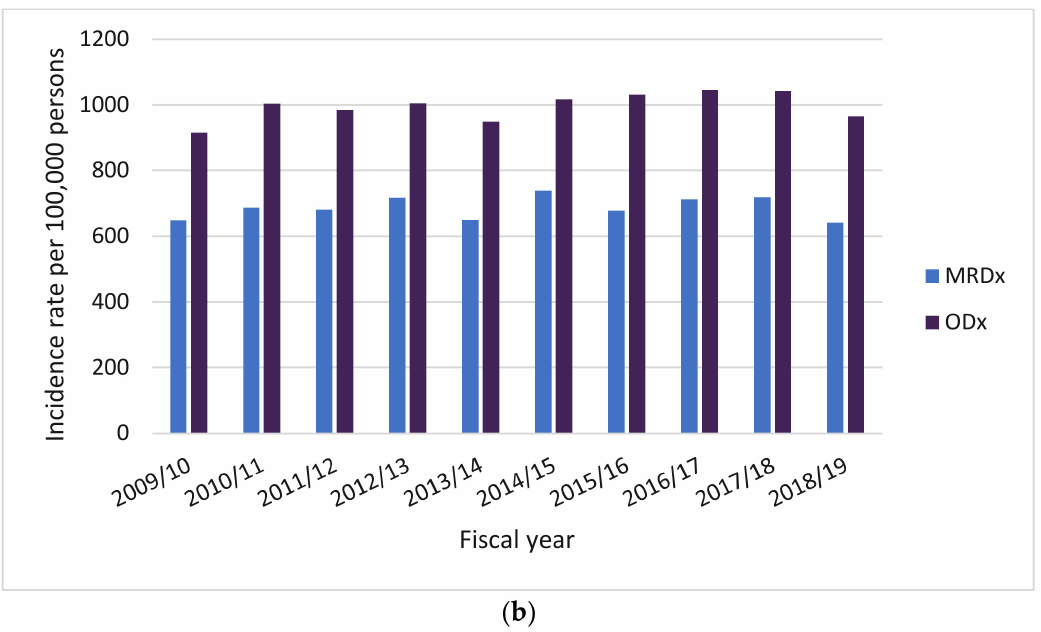
Figure 2. Incidence rates of acute-care hospitalization for all-cause community-acquired pneumonia, by case coding, in fiscal years 2009–2018. Incidence rates are presented for individuals ( a ) 50–64 years old and ( b ) ≥ 65 years old. Incidence rates estimated based on ODx-coded cases are higher than those estimated based on MRDx-coded cases across all age groups. Additional incidence rates per age group and case coding are available in Supplementary Table